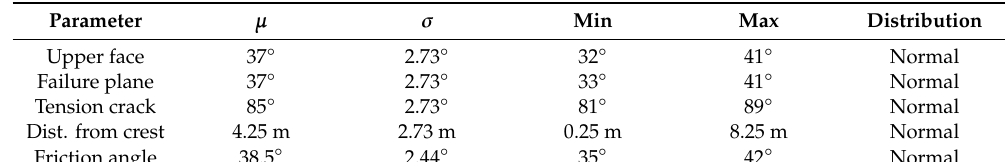
Table 2. Calculation parameters used for the probabilistic analysis of blocks prone to plane failures. Key: µ = mean value; σ = standard deviation.